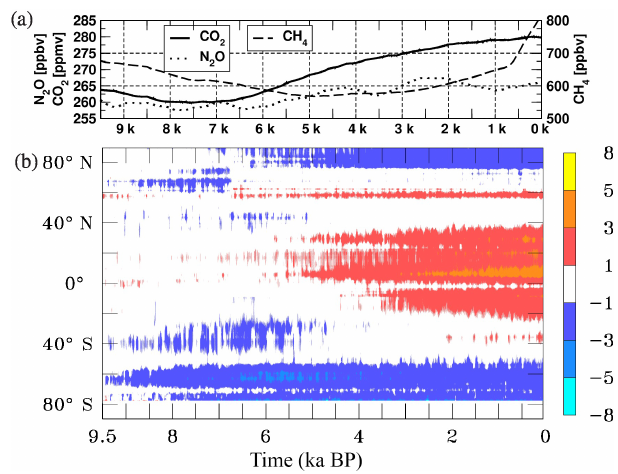
Figure 1. Forcing for the KCM-HOL and BGC-HOL experi- ments: (a) Holocene atmospheric greenhouse gas concentrations (CO 2 ,ppm; CH 4 and N 2 O,ppb) derived from EPICA ice cores (Au- gustin et al., 2004) and provided by PMIP and (b) short-wave radia- tive forcing at the sea/sea-ice surface in Wm − 2 for the BGC-HOL experiment as computed in experiment KCM-HOL (i.e. the astro- nomical TOA changes over the Holocene as shown in Jin et al., 2014 filtered by ECHAM5, the atmospheric component of KCM). Hovmöller diagram of the anomaly of zonal and annual means since 9.5kyrBP as a 50-year running mean. Anomalies are derived by subtracting the average over the first 20 years from the annual mean